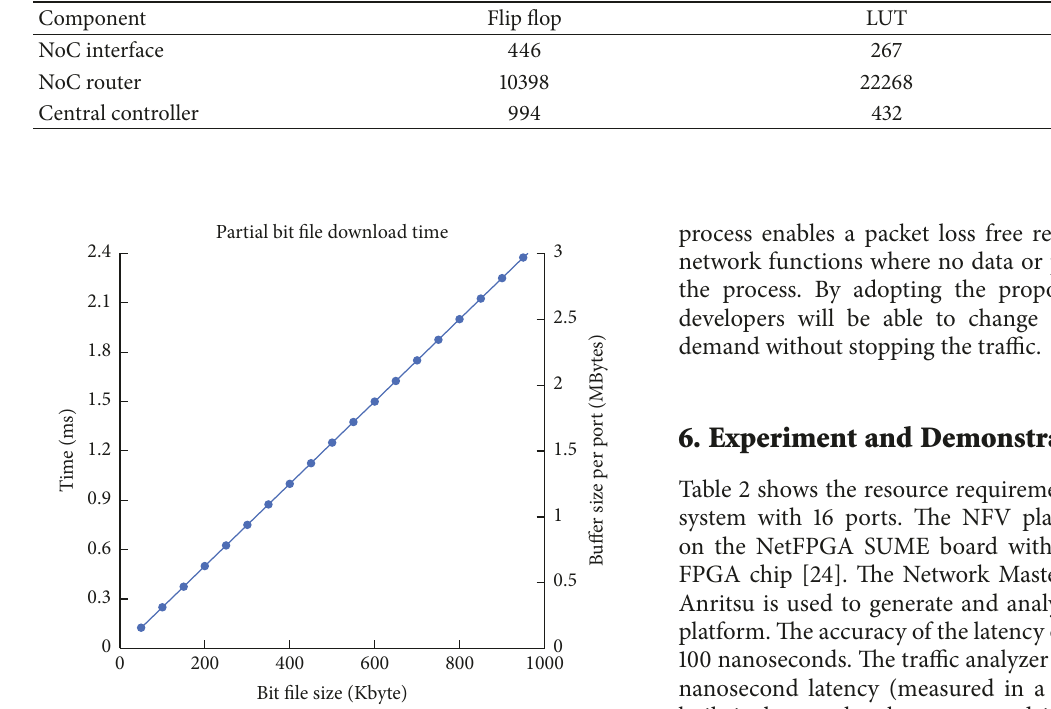
Figure 9: Time and buffer needed for packet loss free partial bitfile download.